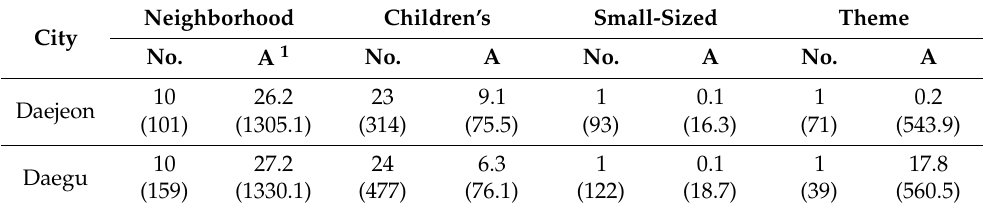
Table 1. The number and area of study